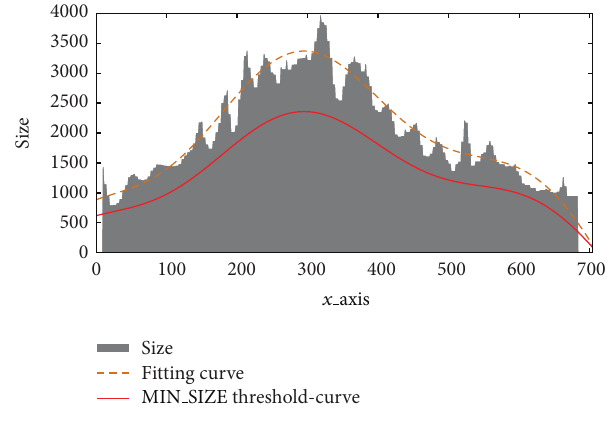
Figure 15: MIN SIZE threshold-curve figure. Table 5: Set MIN SIZE